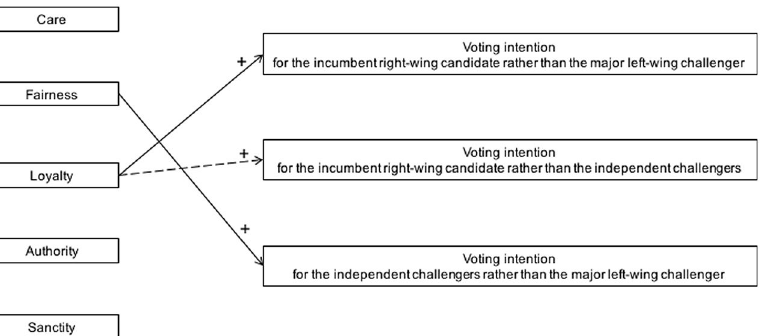
Figure 3. The association between distinct moral foundations and voting intention in 2010 Lombardy regional elections, Study 2. Visualization of the main results obtained in regression analyses, controlling for ideological orientation. The dashed arrow represents a marginally significant